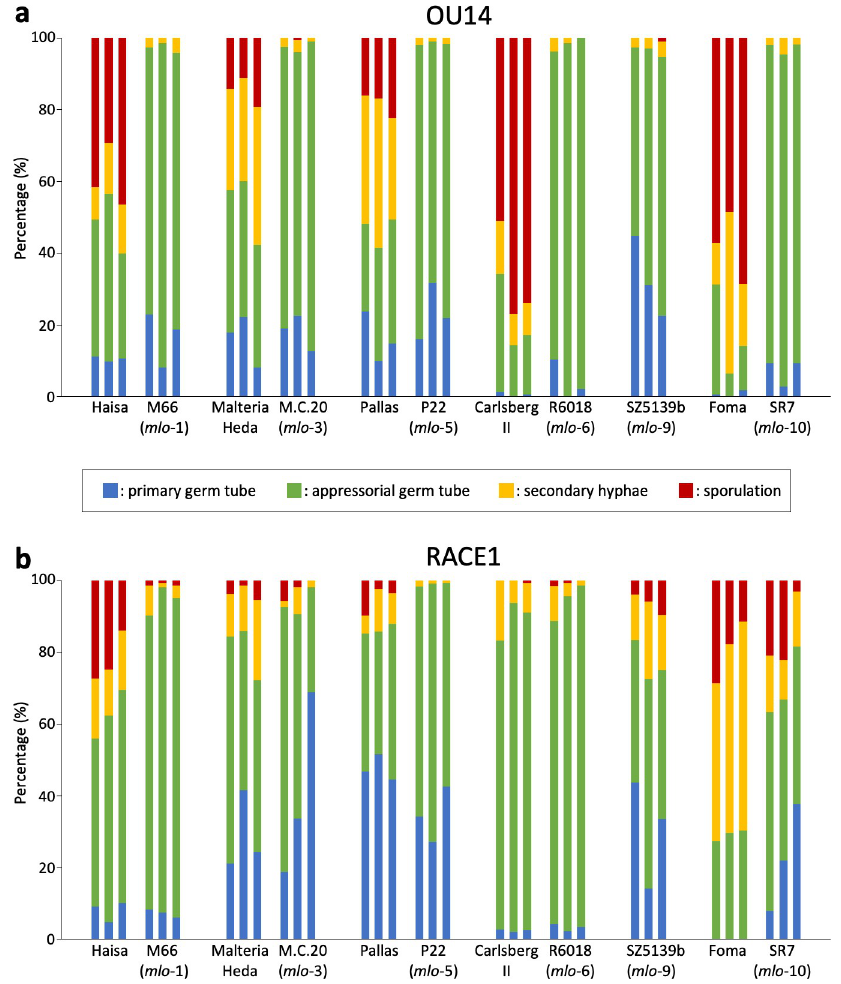
Fig 2. Proportion of the morphogenesis of Blumeria graminis f. sp. hordei races in the mlo mutants. The primary leaves 4 days after inoculation with OU14 ( a ) and RACE1 ( b ) were stained with trypan blue and the morphology of conidia in the situation where only one conidium was in contact with one epidermal cell was counted. The results of three independent experiments on the morphological proportions of about 100 to 200 conidia are shown. Blue indicates conidia arrested with the primary germ tube, green indicates conidia arrested with the appressorial germ tube, yellow indicates conidia arrested with the elongated secondary hyphae, and red indicates conidia that produced new